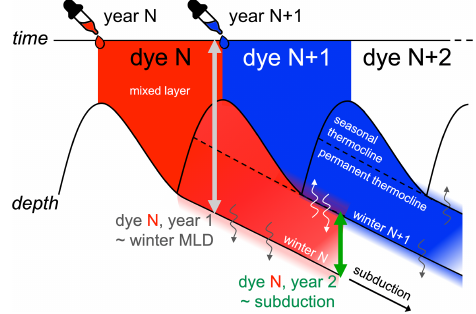
Figure 3. Schematic representation of the injection of dye tracers in the